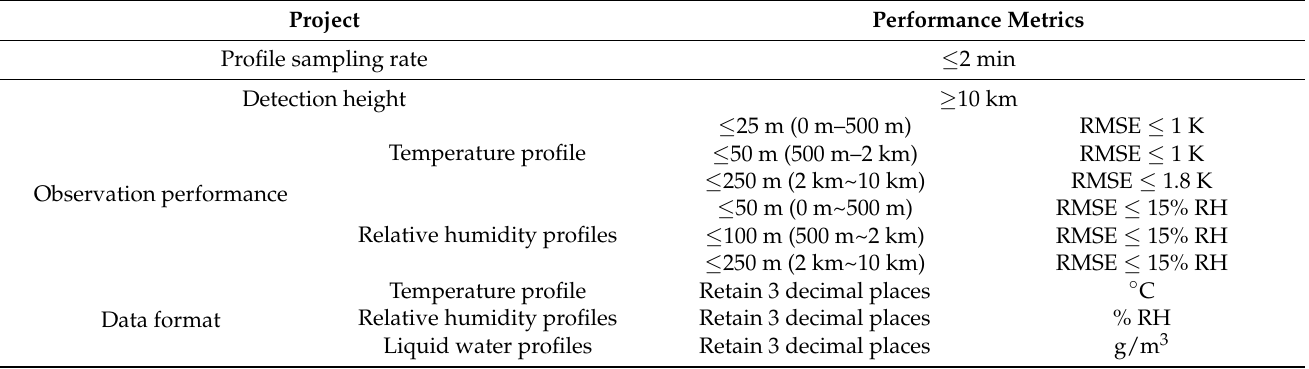
Table 1. Overall detection performance indicators of the MWP967KV ground-based microwave radiometer (RMSE refers to the root mean square